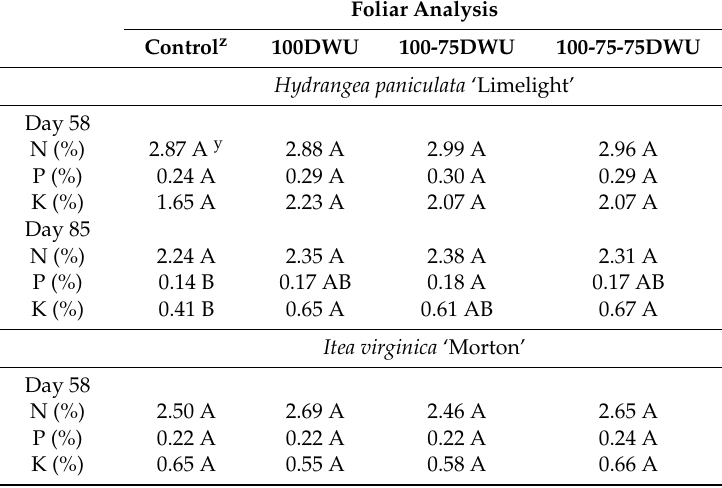
Table 5. Foliar analysis (% dry wt.) sampled on days 58 and 85 of five taxa grown in 10.2 L containers and subject to four irrigation treatments from 11 June (Day 1) to 14 October 2009 (Day 126). Control = 19 mm · application − 1 ; 100DWU = 100% daily water use (DWU) replacement each day; 100-75DWU